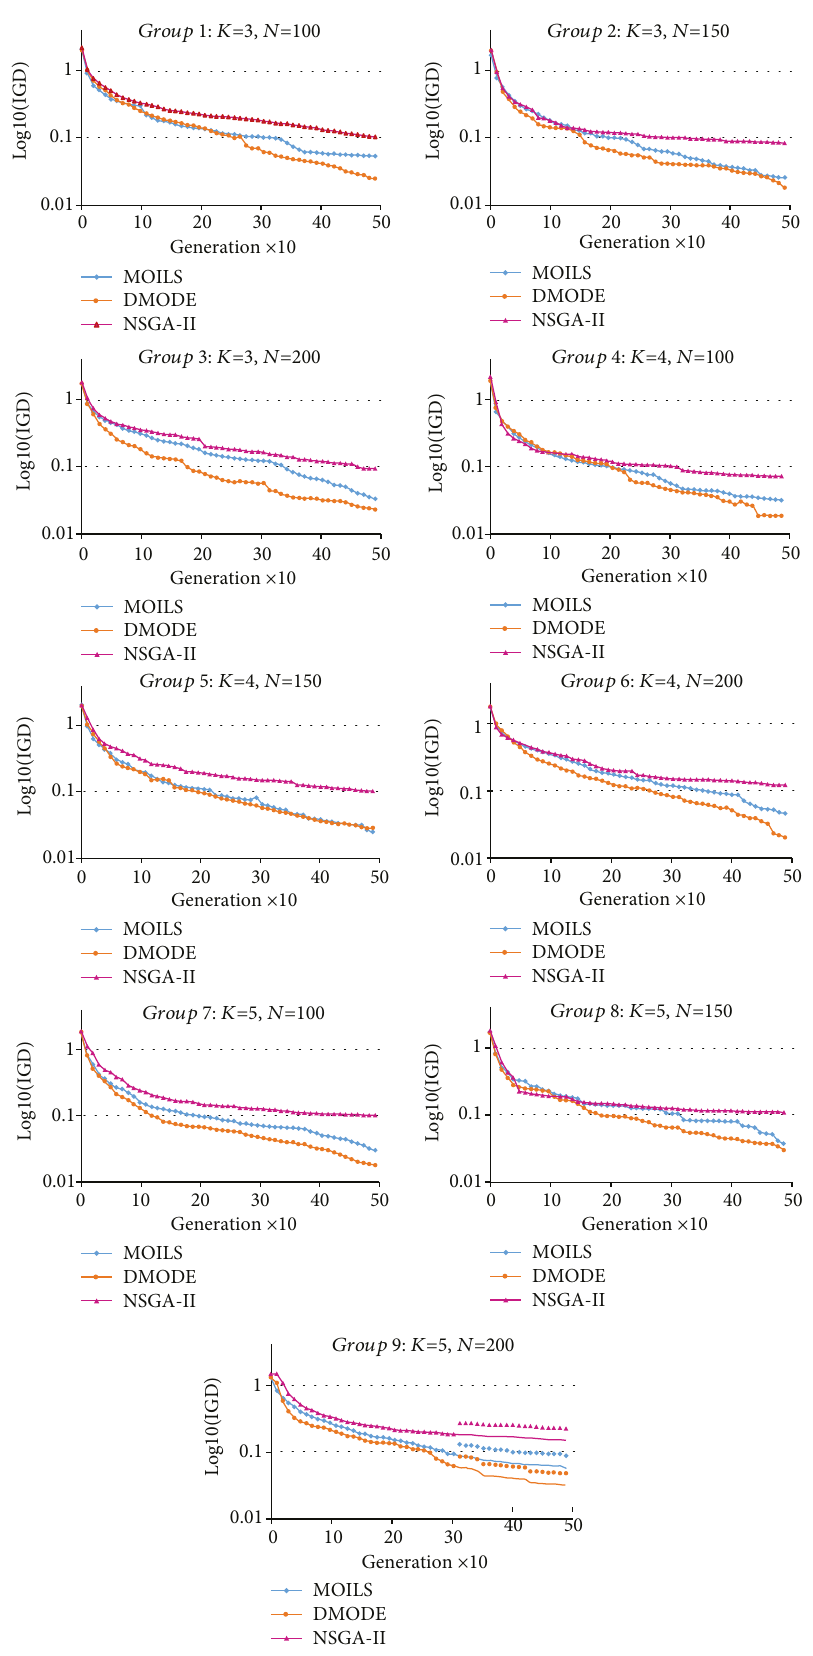
Figure 12: Evolution process IGD metric obtained by NSGA-II, MOILS, and